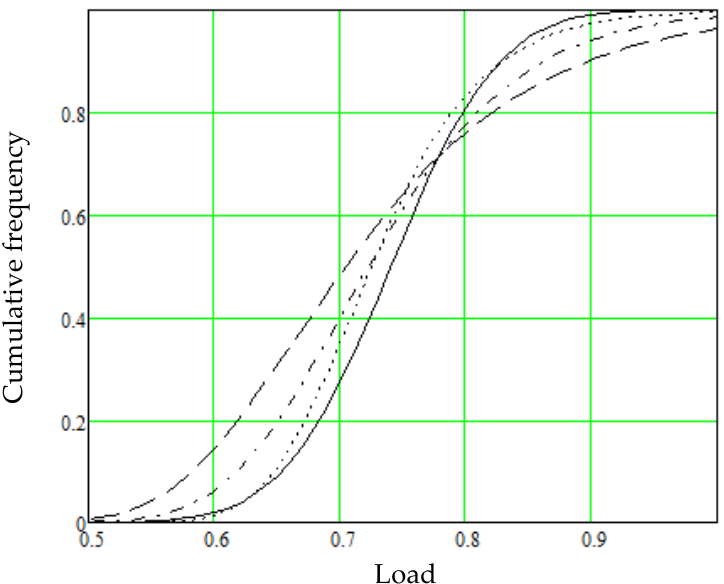
Figure 1. Cumulative load distributions as function of load. The permanent load, solid line; the variable load, dashed line; the DLC, dash-dotted line; the ILC, dotted line combined with 50% permanent load and 50% variable load, α = 0.5. In this Figure unity denotes the mean permanent load and the 50-year return load of the variable load.